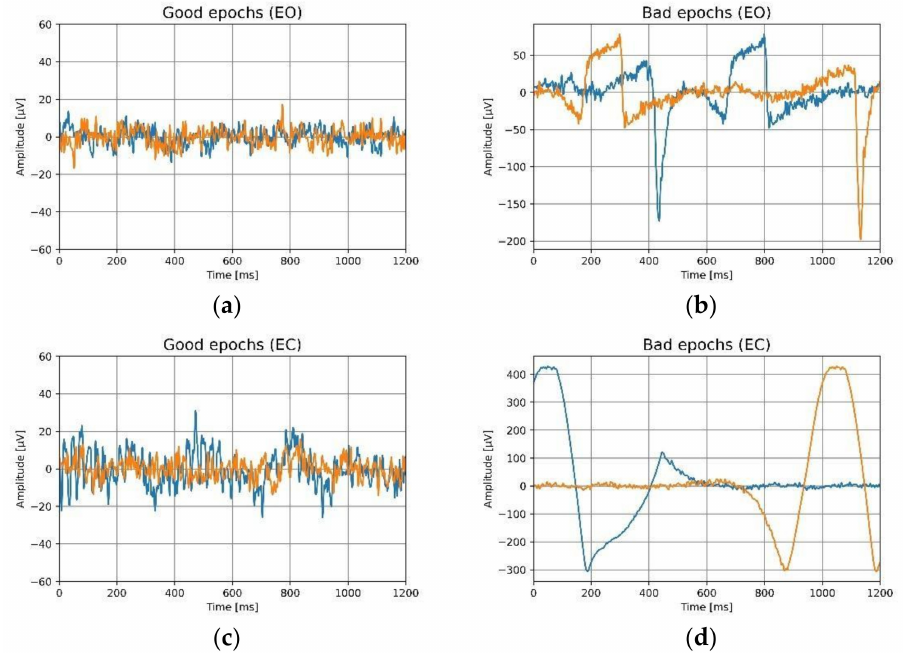
Figure 12. For eyes-open (EO) and the eyes-closed (EC) conditions, the epochs of the forehead elec- trodes are shown. Two distinct epochs are indicated by two distinct colors, ( a ) good epochs for eyes- open, ( b ) bad epochs for eyes-open, ( c ) good epochs for eyes-closed, ( d ) bad epochs for eyes-closed.